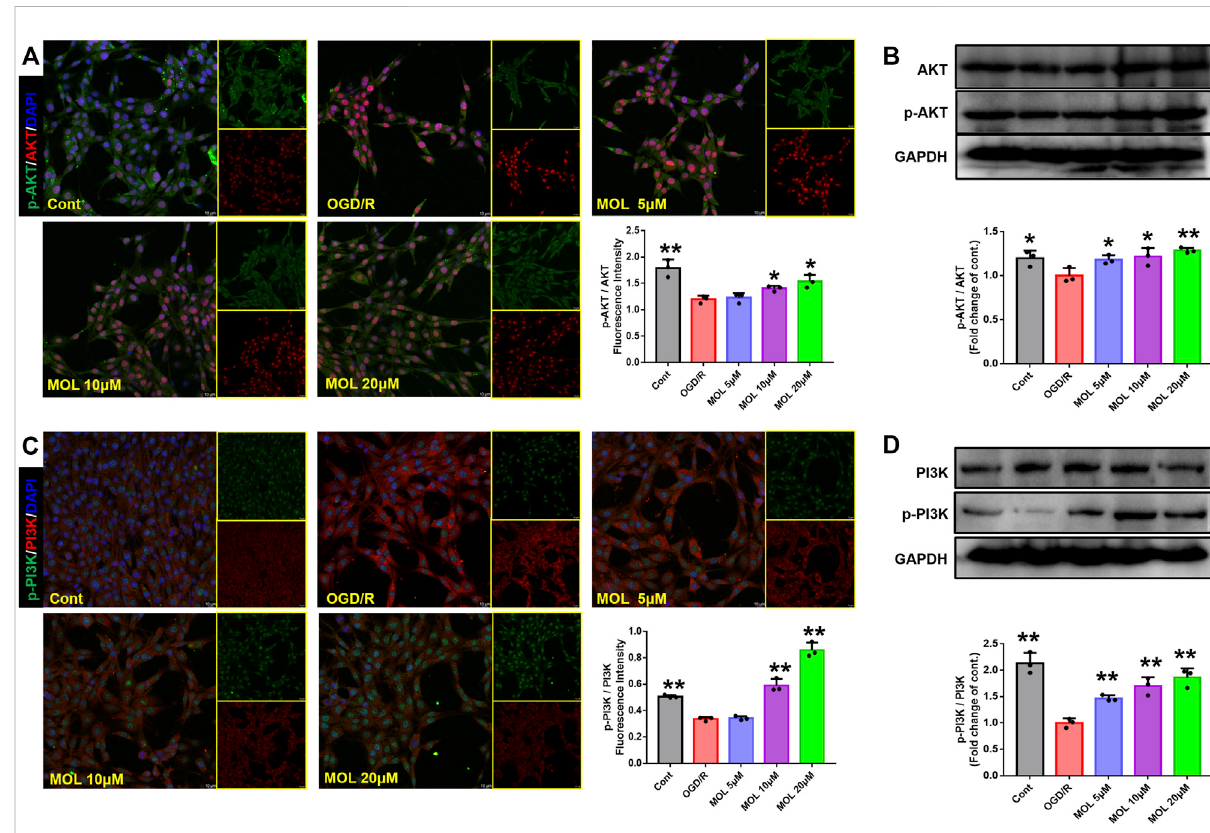
FIGURE 8 MOL treatment can activate the PI3K/AKT pathway in SHSY-5Y cells induced by OGD/R. (A) and (B) MOL (5, 10, 20 μ M) treatment can up- regulate the phosphorylation level of AKT and increase the p-Akt/AKT ratio in SHSY-5Y cells induced by OGD/R. (C) and (D) MOL (5, 10, 20 μ M) treatment can up-regulate the level of PI3K phosphorylation in SHSY-5Y cells induced by OGD/R, and increase the ratio of p-PI3K to PI3K. Data expressed as Mean ± SD, ** p < 0.01, * p < 0.05 vs. OGD/R